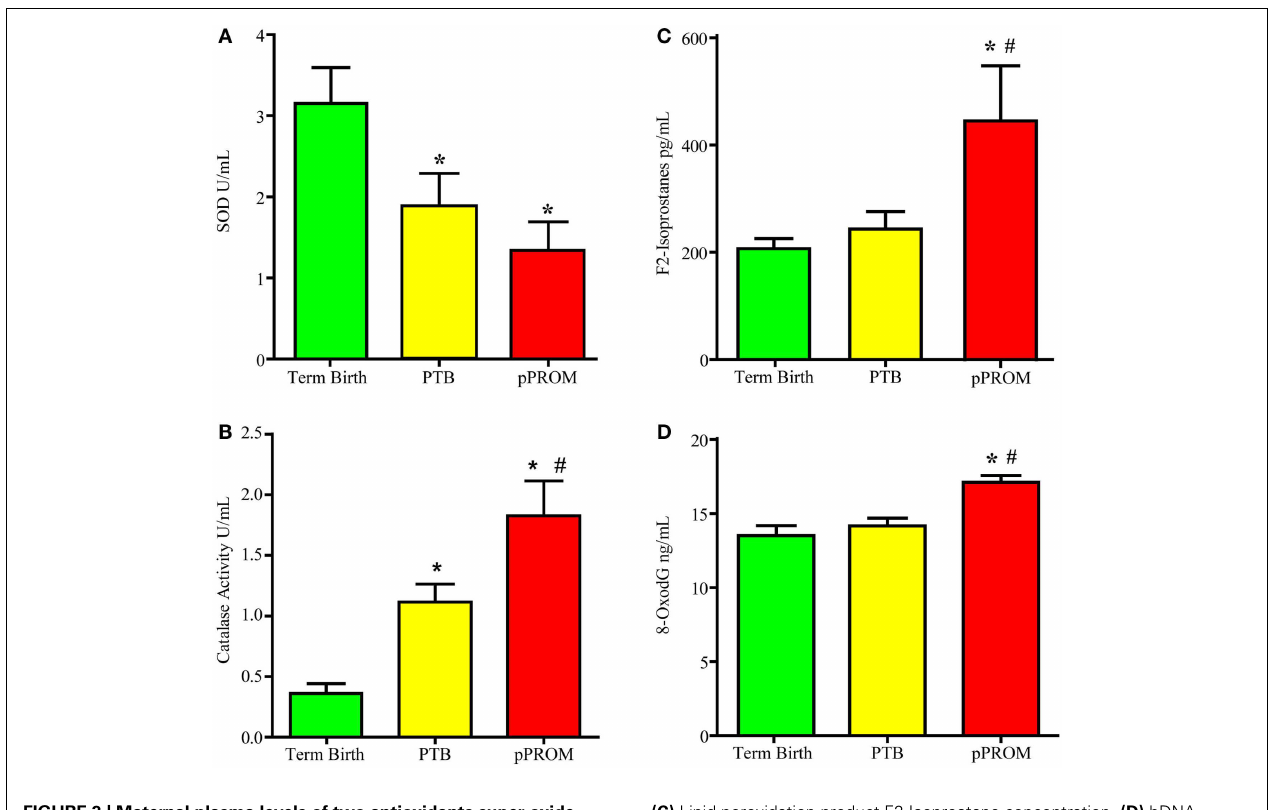
FIGURE 3 | Maternal plasma levels of two antioxidants super oxide dismutase (SOD) and catalase and two OS markers, 8-oxodG and F2-Isoprostanes . (A) Antioxidant enzyme Super oxide dismutase concentrations. (B) Antioxidant enzyme catalase concentrations.